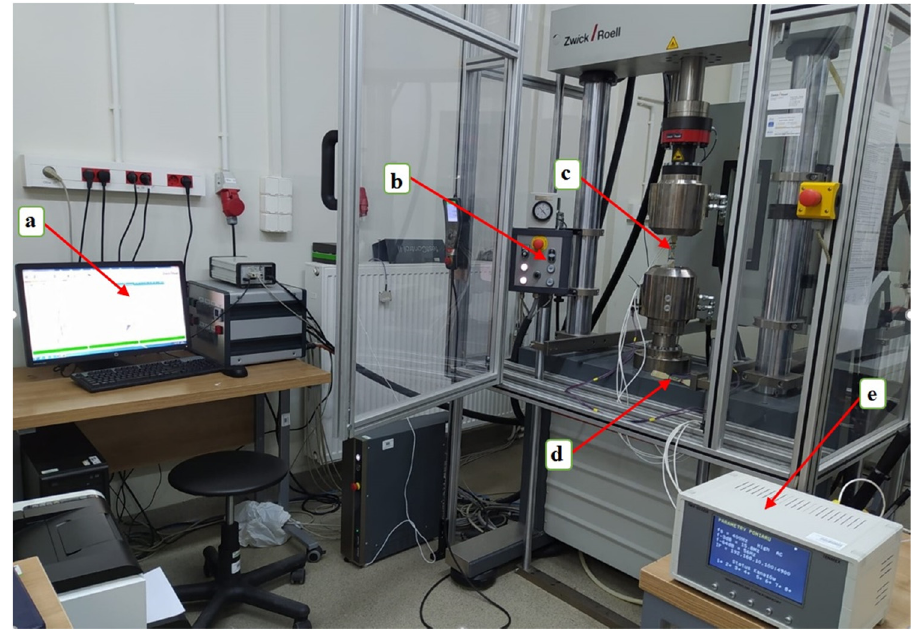
Figure 8: View of the Zwick Roell testing machine during the test. Computer stand ( a ) , control panel of the machine ( b ) , fi xed composite sample ( c ) , temperature compensation sample ( d ) and strain gauge measuring system ( e )